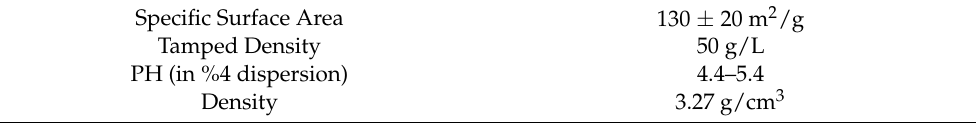
Table 2. The properties of Al 2 O 3 nanoparticles, which were used for nanofluid preparation [48]. Specific Surface Area